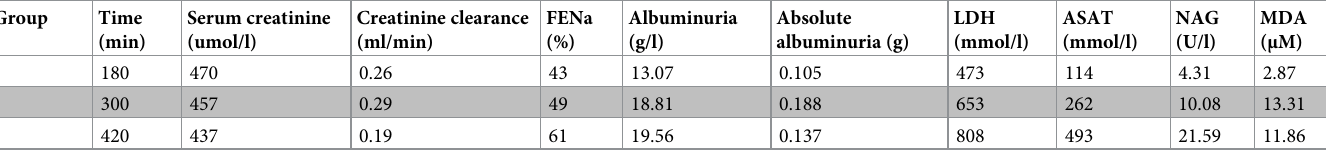
PLOS ONE | https://doi.org/10.1371/journal.pone.0251595 May 18,